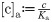
Stochastic and deterministic time evolution of protein (XapA/XapB) and adaptation time.(A) Shown in blue is the result from one typical run of the stochastic simulation, and in orange the trajectory obtained from solving the deterministic ODE’s. In light blue, two more extreme runs of the simulation are shown for comparison. The simulation was run for 5 ⋅ 105 s each and started at an mRNA, protein and intracellular xanthosine count of 0. The parameters that were used are the same as in Table 1, the only exception being the extracellular xanthosine concentration, which was chosen to be [c]a = 25 (recall [c]a≔cKa, Ka = 5 ⋅ 10−5 M) just as in Fig 9(C). (B) In blue we plot the waiting time distribution for 1000 runs of the simulation (same conditions as (A)) to reach the steady-state mean. We define this time as the elapsed time when the protein copy number first reaches 90% of its value at the upper fixed point. To better visualize the bulk of the distribution, we excluded from the plot ∼10 runs with adaptation times larger than 6 ⋅ 105 s. The green dashed line indicates the mean of the blue distribution. The orange line shows the corresponding deterministic time.